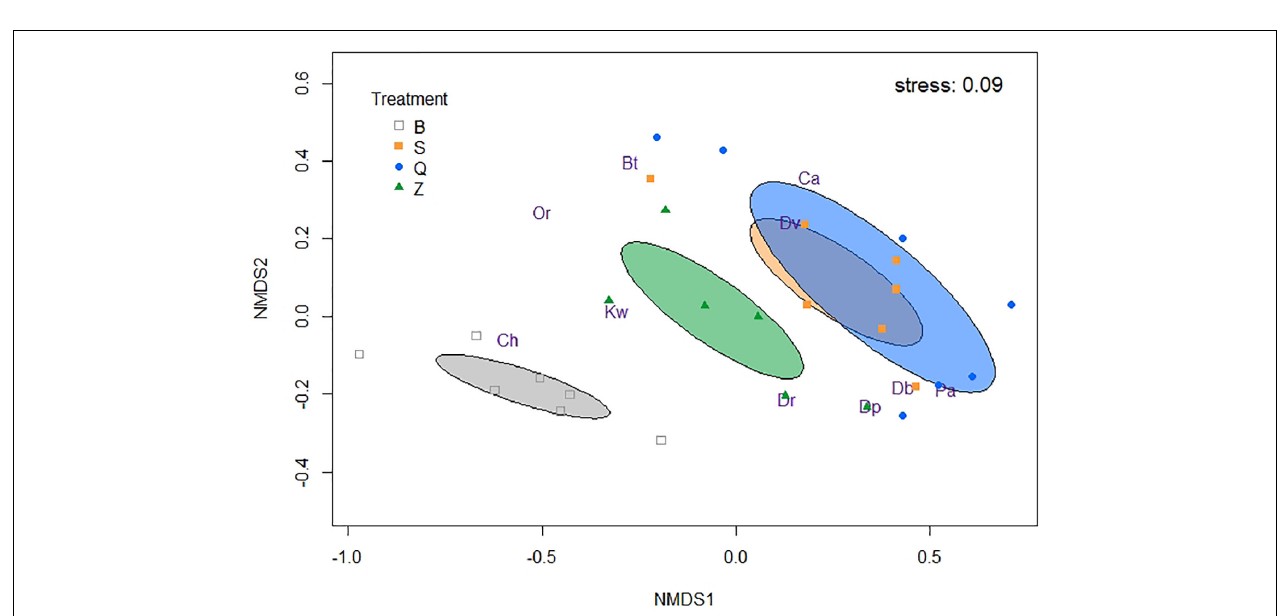
FIGURE 2 | Non-metric multidimensional scaling (NMDS) ordination plot of newly settled macroinvertebrate abundances, representing the community structure in four different treatments. Ellipses draw standard errors of the treatments and show a 95% confidence interval. Db means D. rostriformis bugensis , Dp means D. polymorpha , Dr means Dreissena ( ≤ 1 mm), Pa means P. antipodarum , Bt means B. tentaculata , Dv means D. villosus , Kw means K. warpachowskyi , Ca means Caenis , Ch means Chironominae, and Or means Orthocladiinae.